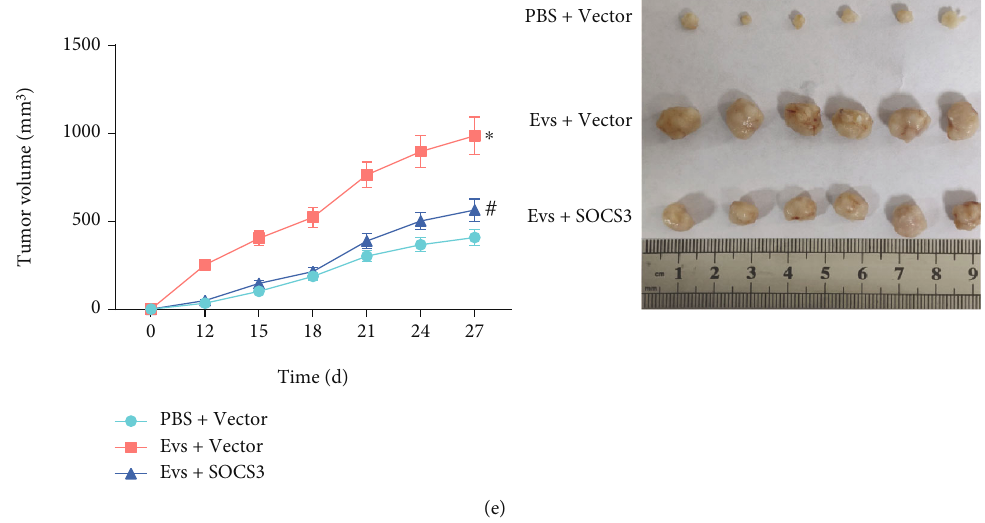
Figure 7: E ff ects of ADSC-EVs carrying NEAT1 on PCa progression and gemcitabine resistance via miR-491-5p/Snail/SOCS3 axis. SW1990 cells were treated with EVs alone or combined with overexpressed SOCS3. (a) Expression of NEAT1 and miR-491-5p determined by RT- qPCR and protein levels of Snail and SOCS3 in SW1990 cells determined by Western blot analysis. (b) Clonogenic potential of SW1990